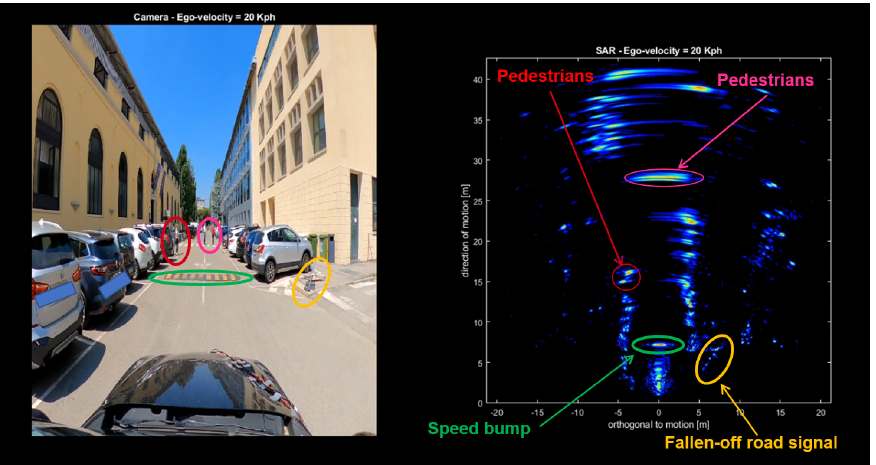
Figure 10. SAR imaging in a closed road (forward-looking configuration): ( left ) camera image; ( right ) SAR image. In the green circle, the speed bump is visible, while in the yellow one, a fallen-off road signal is depicted. In the red and purple circles some pedestrian are highlighted.